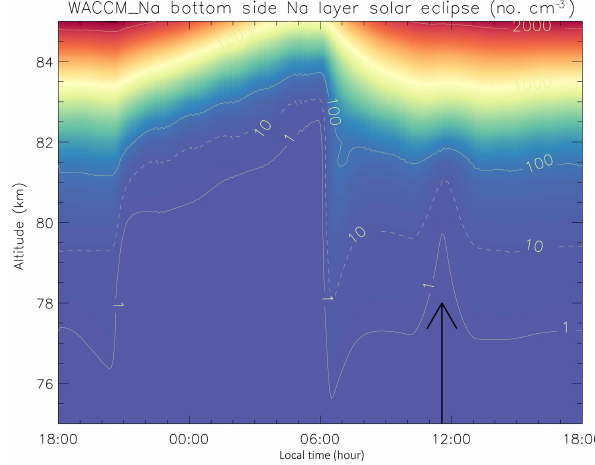
Figure 6. A 1-D model simulation of the Na layer variation dur- ing the solar eclipse between 18:00LT on 20 August and 18:00LT 21 August in 2017. The solar eclipse at the USU Na lidar location peaked at 11:34 on 21 August (marked by the solid arrow). The background atmospheric species (O 3 , O, H, etc.) are based on the outputs of WACCM-X eclipse